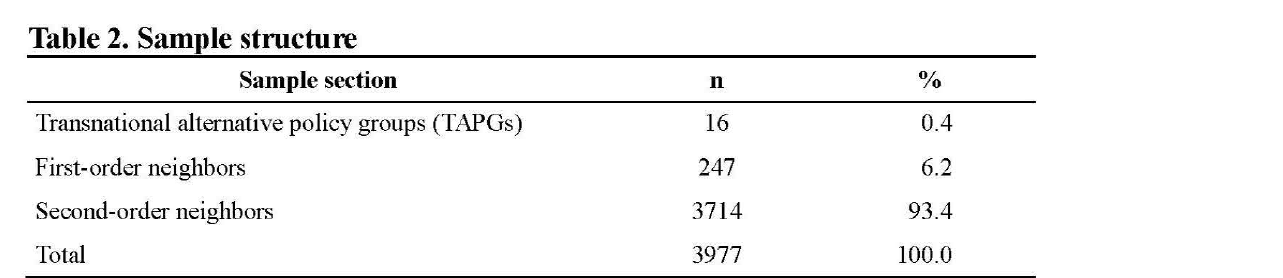
Table 2. Sample structure